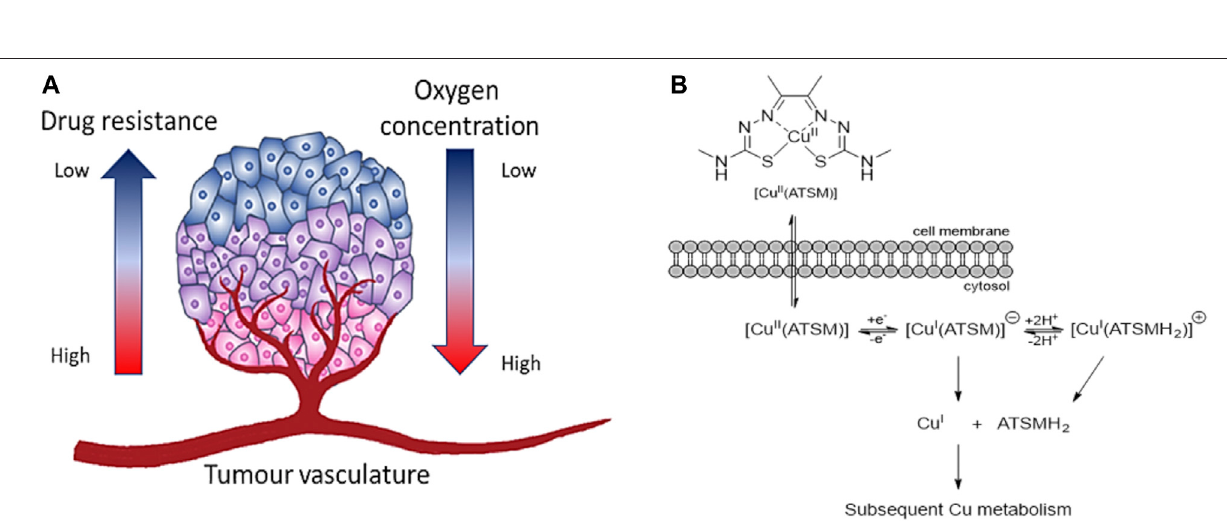
Frontiers in Chemistry |